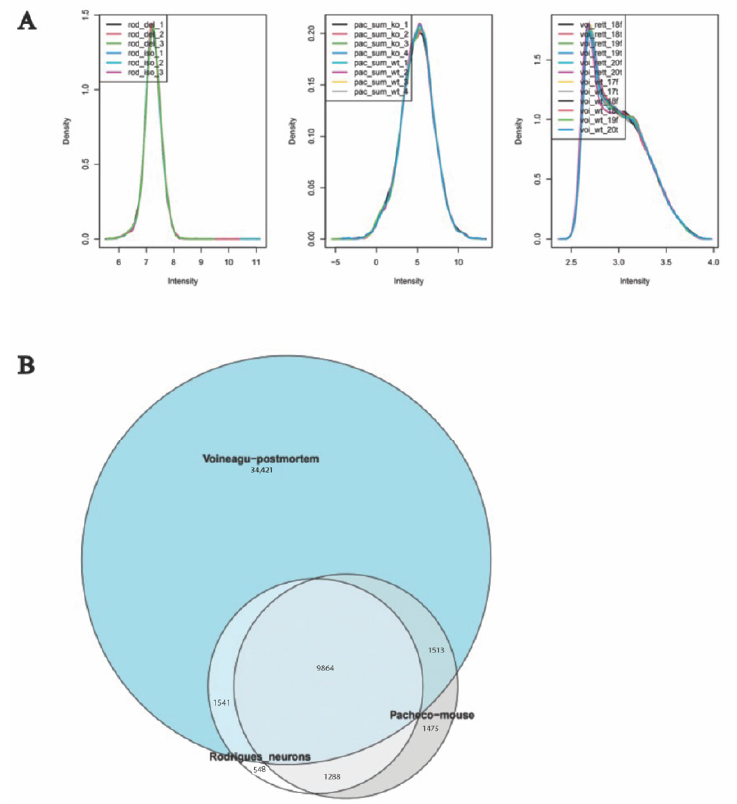
Figure 2. Data pre-processing. ( A ) Normalisation of datasets. Each panel represents a study in the following order (left to right): Rodrigues, Pacheco and Voineagu, each color line represents a sample. ( B ) Venn diagram showing genes in common between the three datasets.